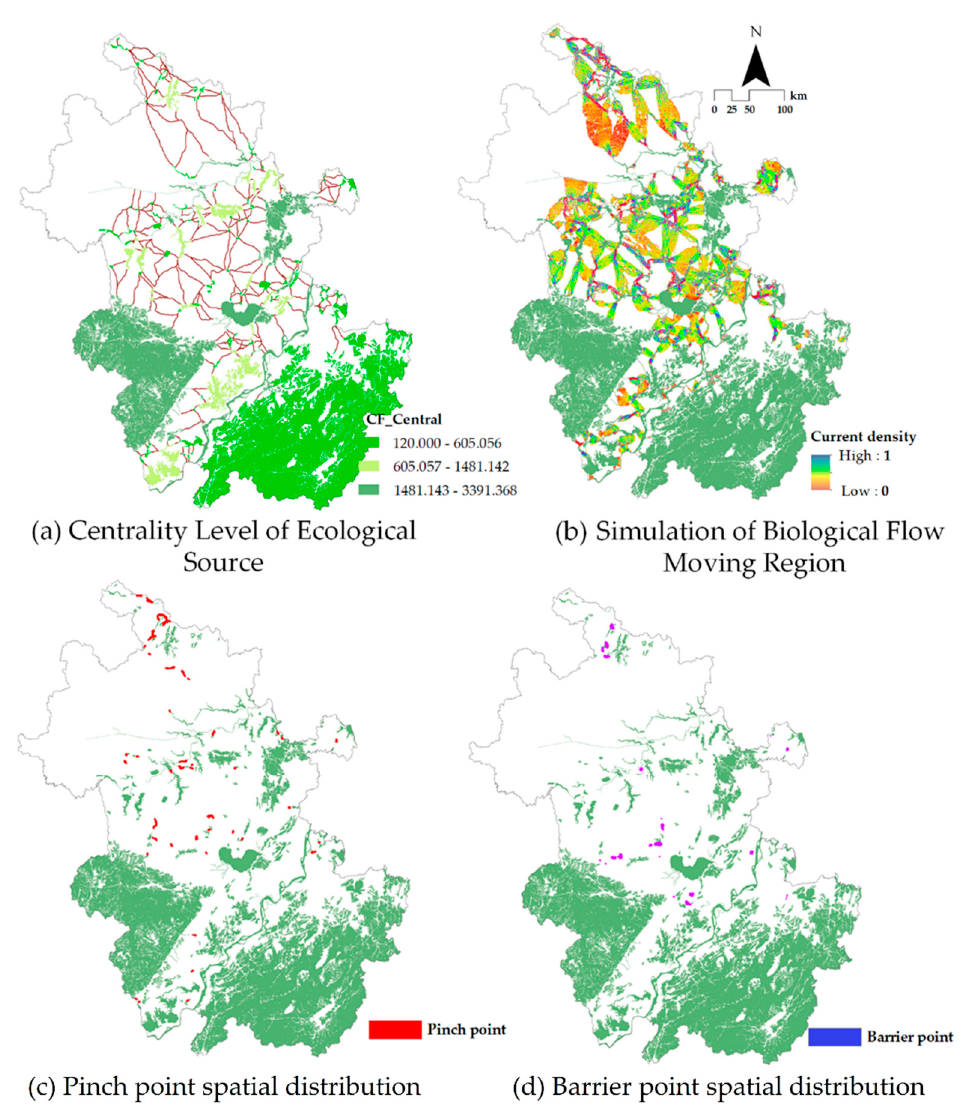
Figure 8. Analysis of the elements of ecological security patterns in Anhui Province.